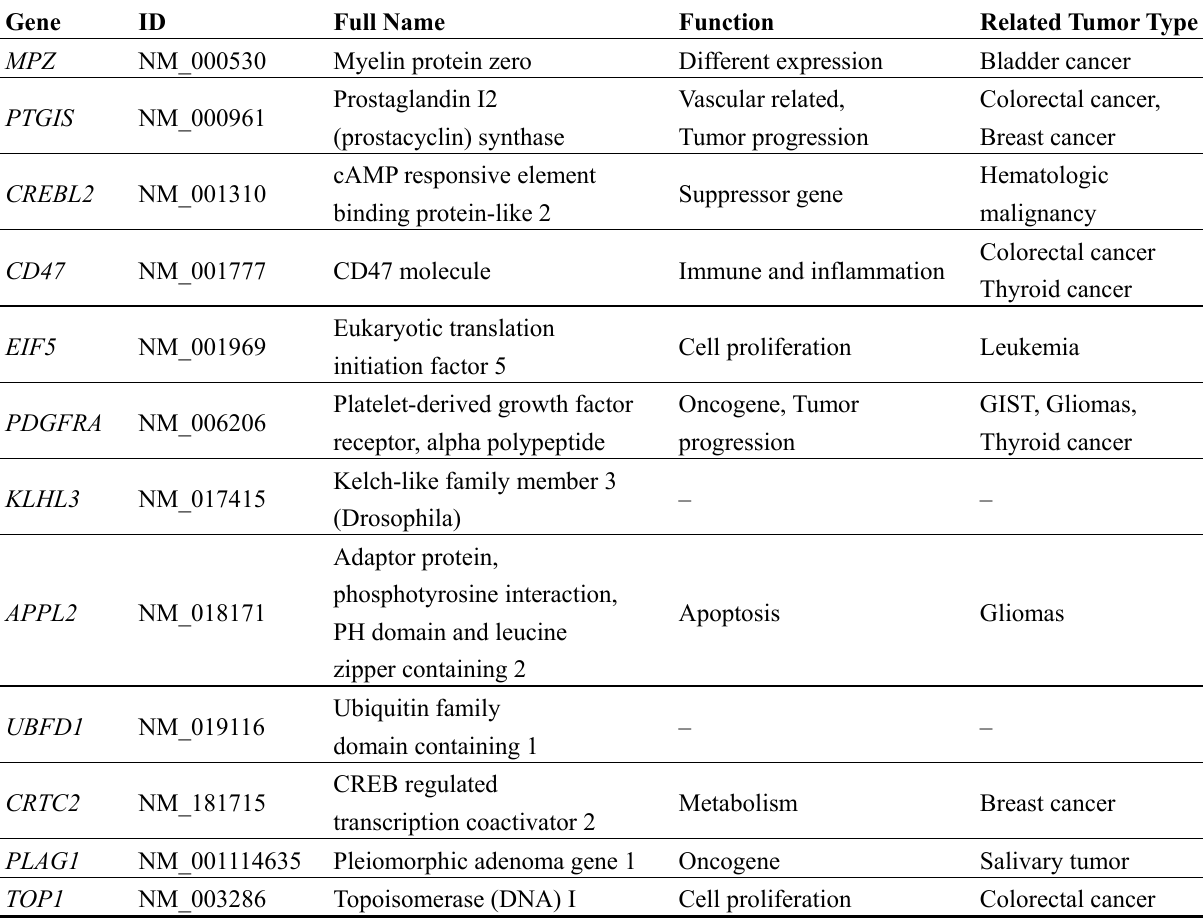
Table 5. Predicted most probable target genes of has-mir-149-5p